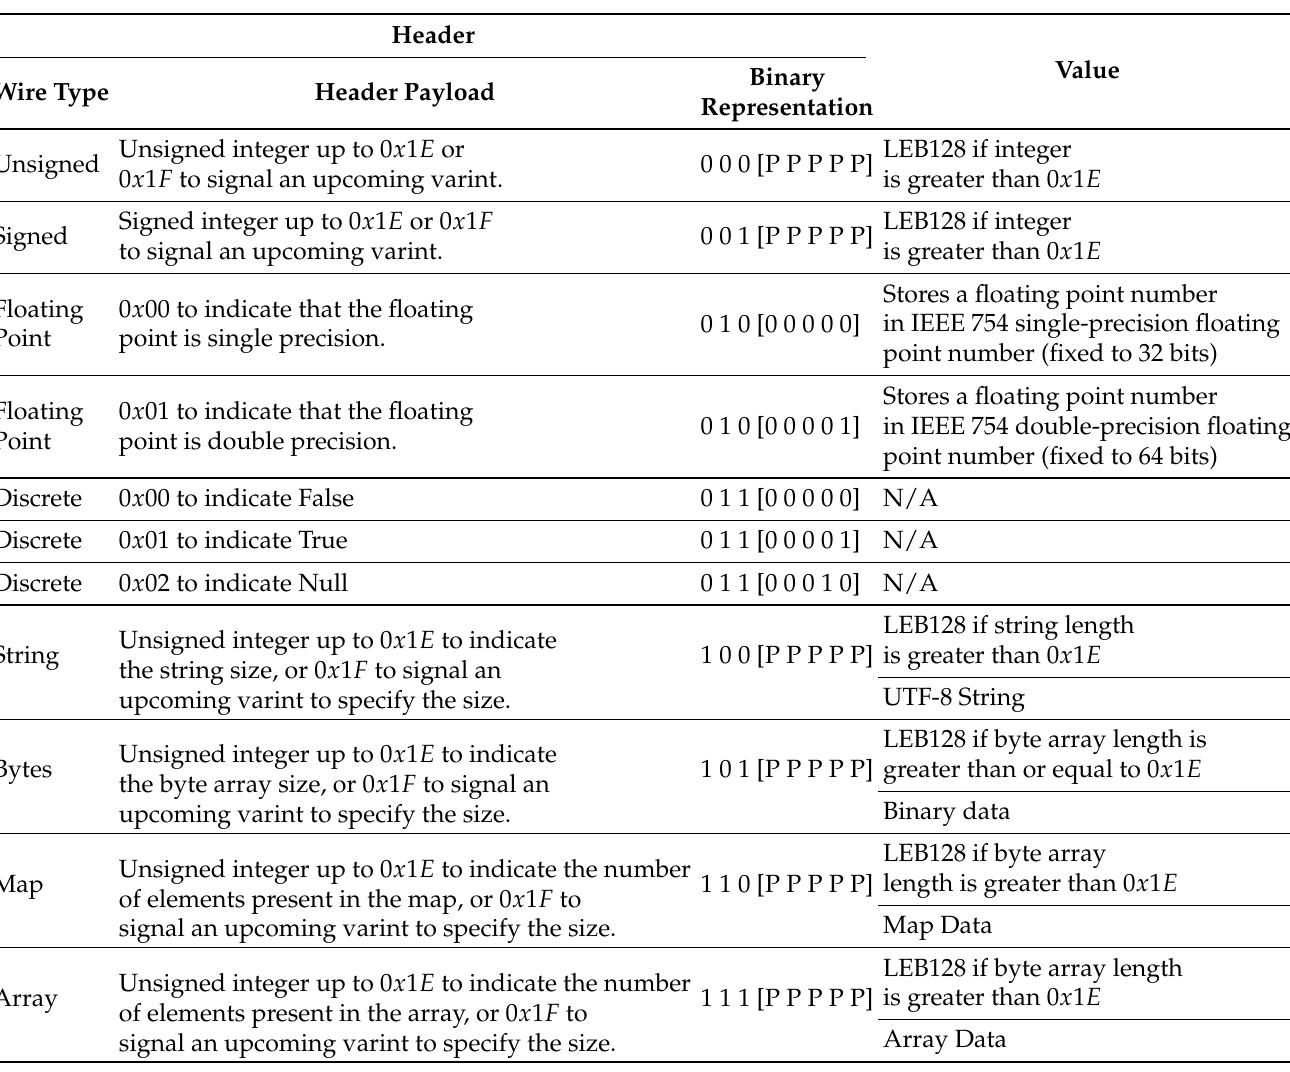
Table 1. Encoding rules for different PSON wire